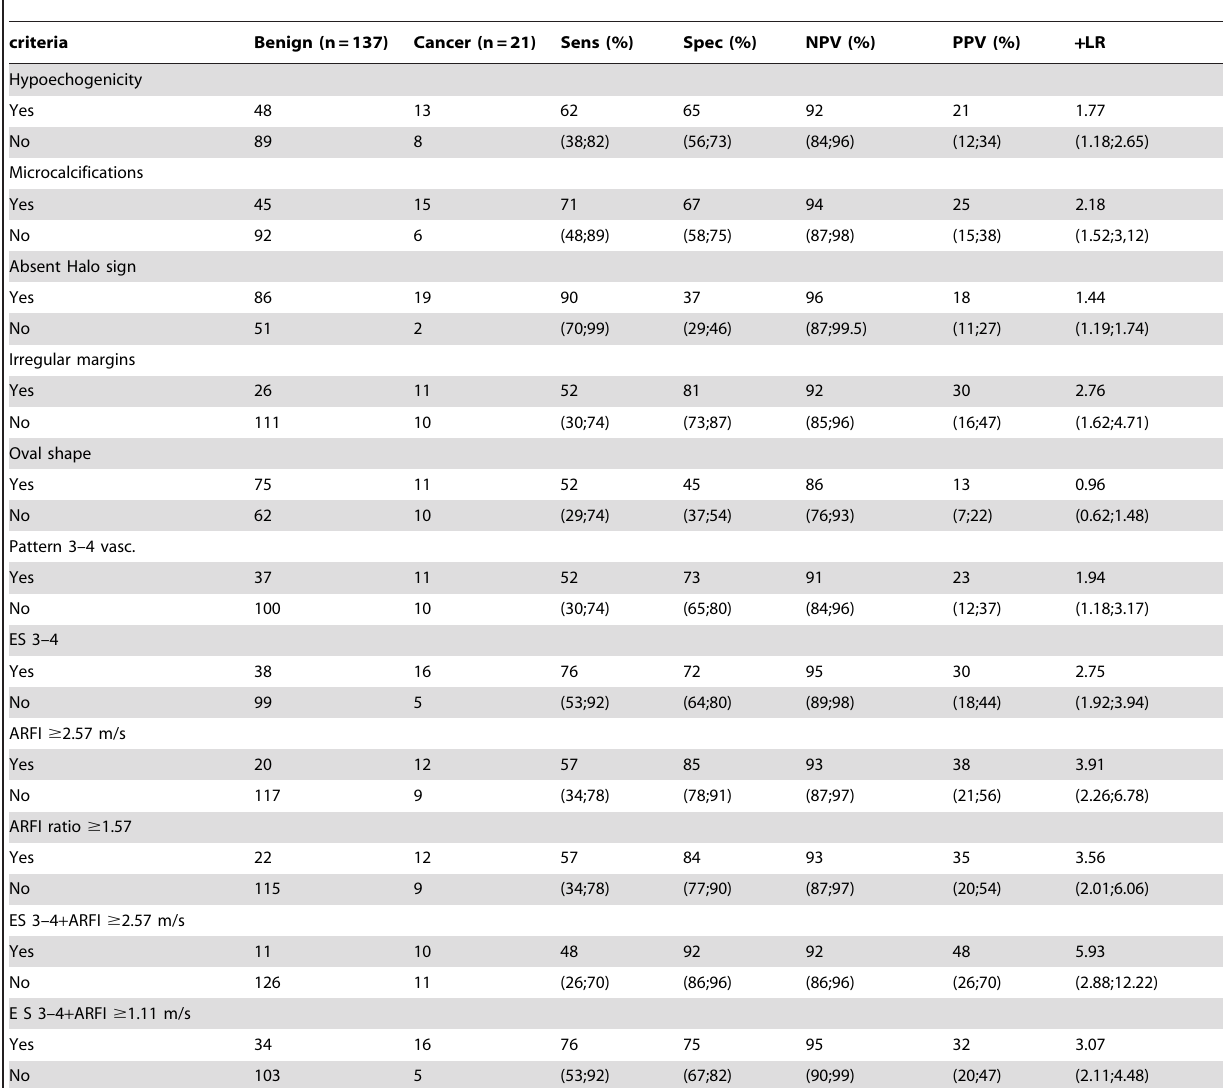
Table 2. Senstivity, specificity, PPV and NPV for thyroid cancer for different ultrasound patterns (including RTE and ARFI) in thyroid